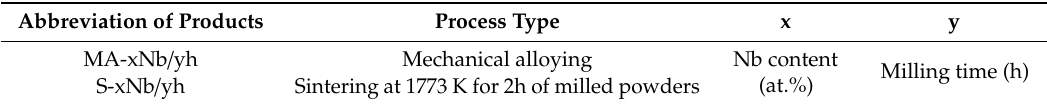
Table 1. Conditions and corresponding